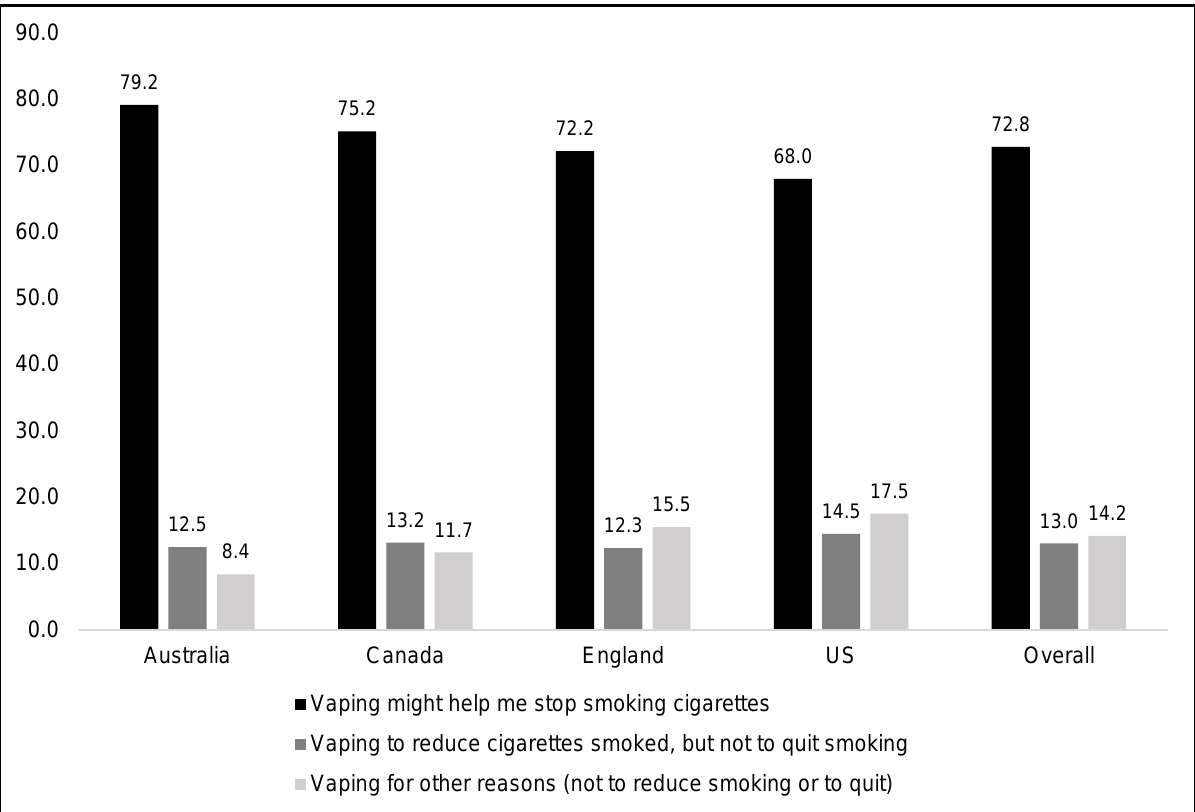
Figure 2. Reasons for vaping among current smokers: quit-reduce smoking versus other reasons only, (% yes, weighted) . N = 2467. Data are weighted and adjusted for sex, age, income, education, and vaping frequency.